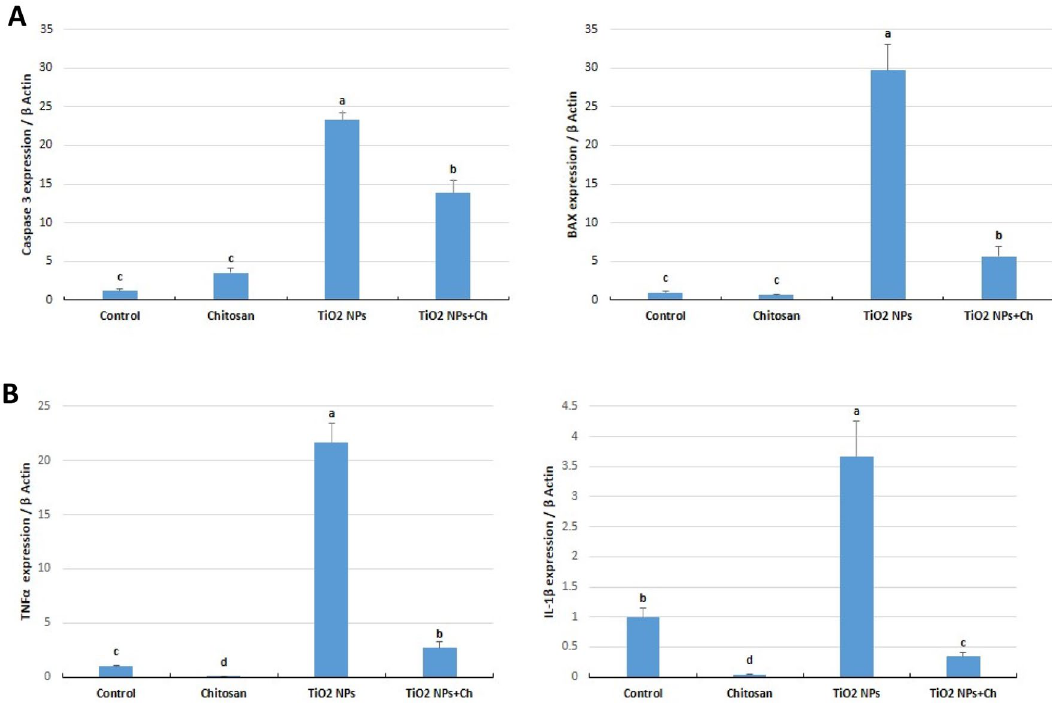
Figure 6. Effects of TiO 2 NPs and/or chitosan on the expression of pro-apoptotic ( A : Caspase 3; BAX) and pro- inflammatory ( B : TNFα and IL-1β) mRNAs. Data are presented as means ± SE. The different letters (a, b, c, d) indicated significant difference ( p < 0.05) between experimental